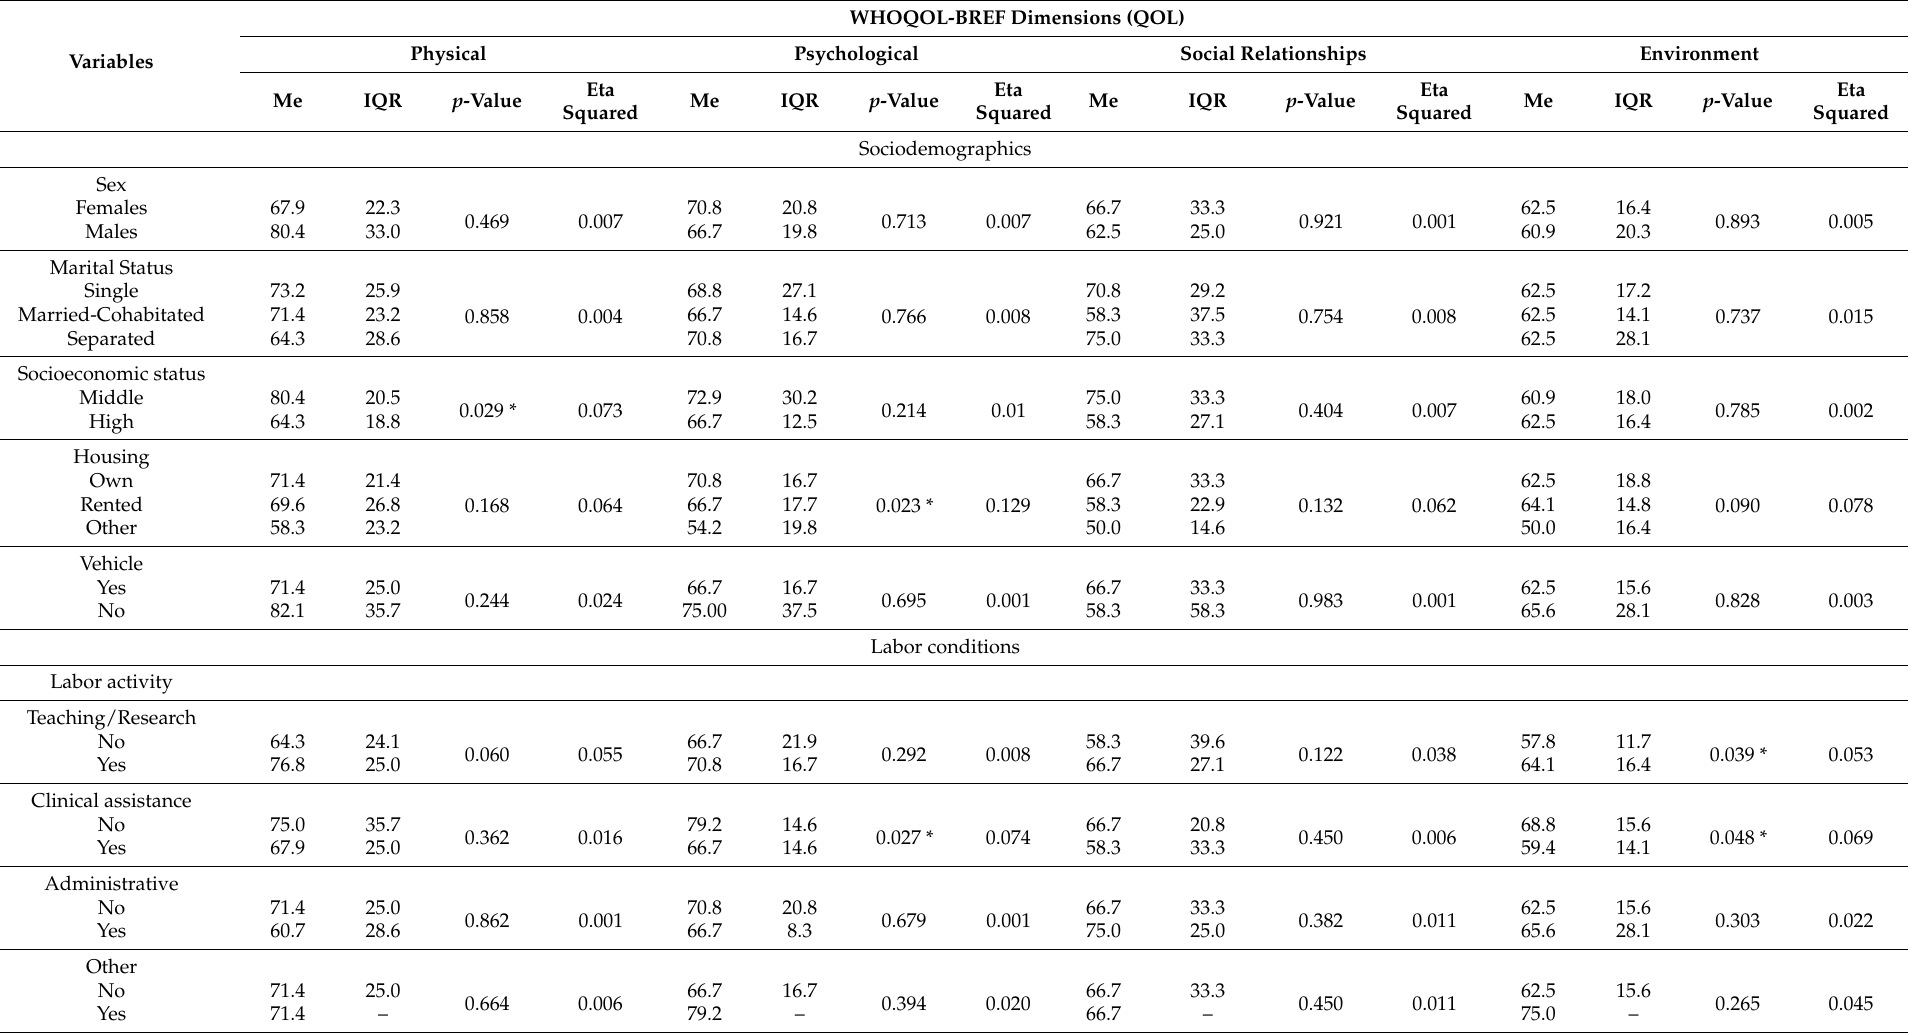
Table 3. Differences in QOL levels according to the various sociodemographic, labor, and health variables in the study sample. Medellin, 2021–2022 ( n =